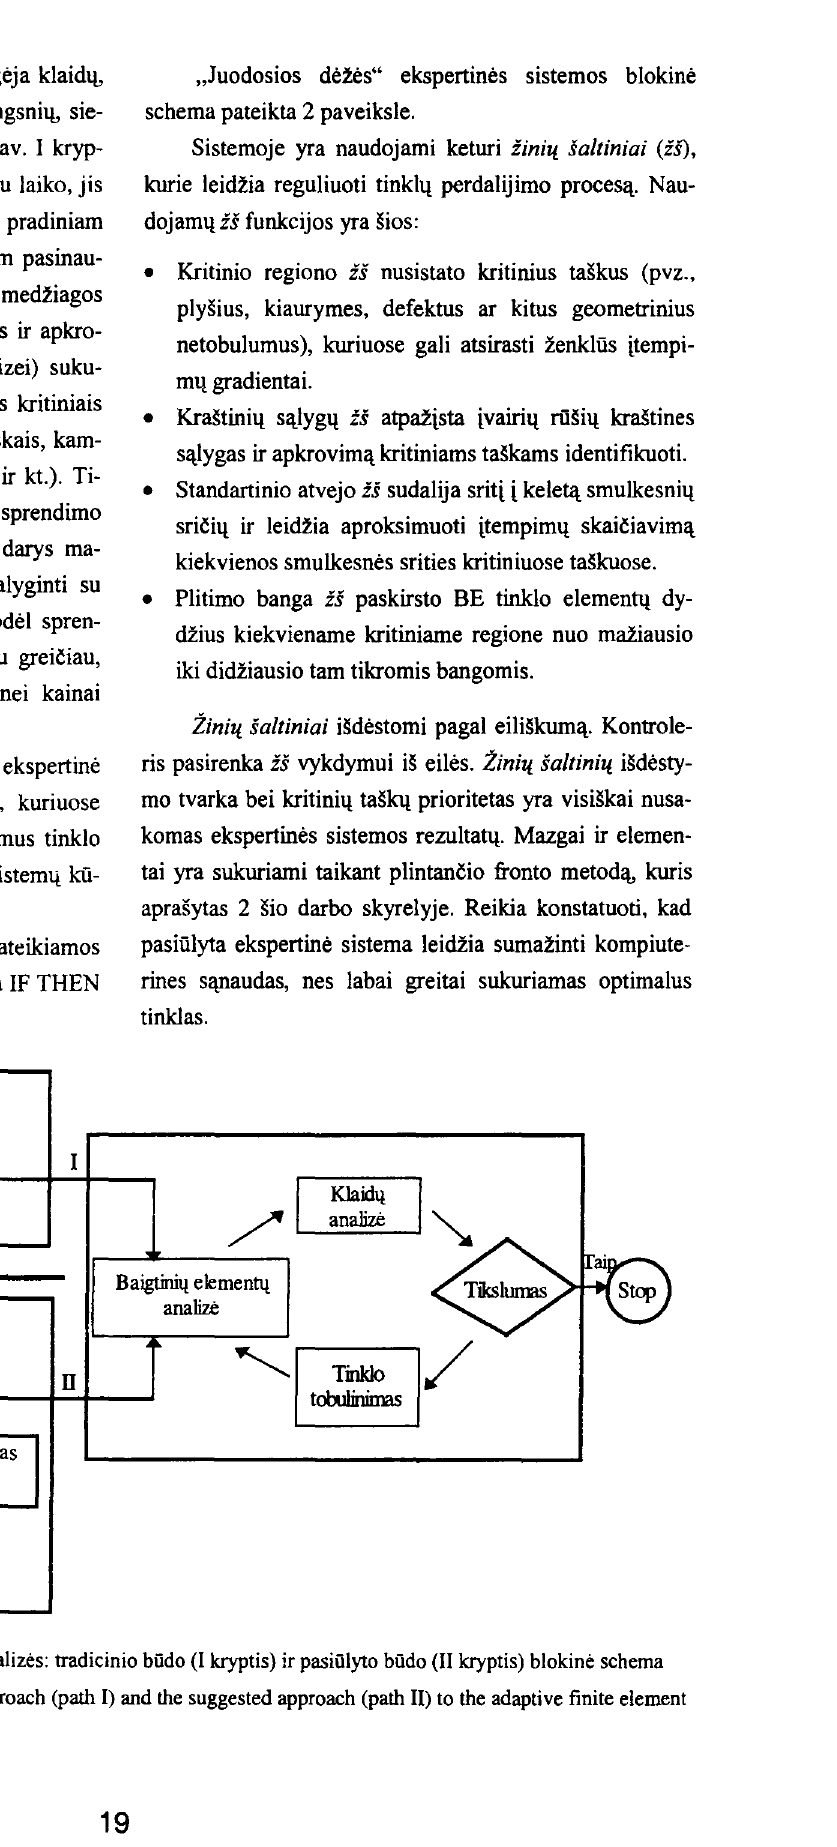
Fig 1. Schematic diagram of the traditional approach (path I) and the suggested approach (path II) to the adaptive finite element